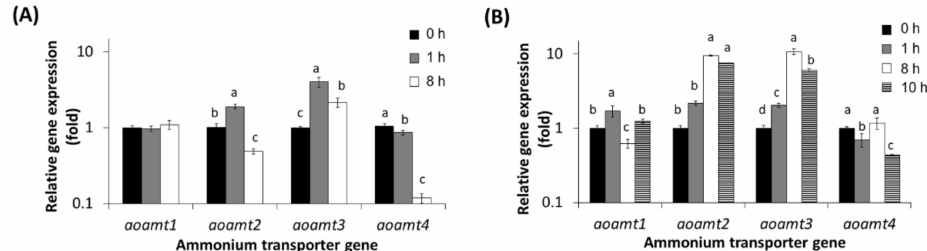
Figure 4. Differential expression of aoamt genes in A. oryzae . Expression analysis of aoamt1 , aoamt2 , aoamt3 , and aoamt4 genes of the wild-type cultures grown in modified Czapek Dox (mCD) medium in the presence of 1 mM NH 4 Cl ( A ) and 20 mM NH 4 Cl ( B ) was carried out by RT-qPCR. Total RNA was extracted from the cultures after medium transfer for 0, 1, 8, and 10 h (black, gray, white, and horizontal bars, respectively). The expression level of each gene at 0 h (black bars) was adjusted to 1. Different letters (a, b, c, and d) above the bars indicate a statistically significant difference in the transcript levels of each gene at various time points analyzed by Duncan’s multiple range test (MRT) ( p -value < 0.05). The mean standard deviation (mean SD) of the expression level is derived from ± ± triplicate